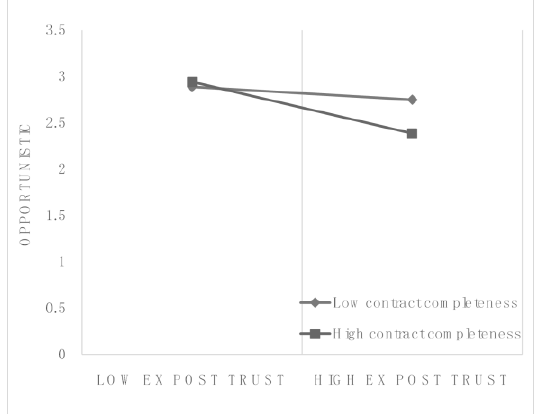
Figure 5. Interaction effect of CC and EPT. Note: source own elaboration.